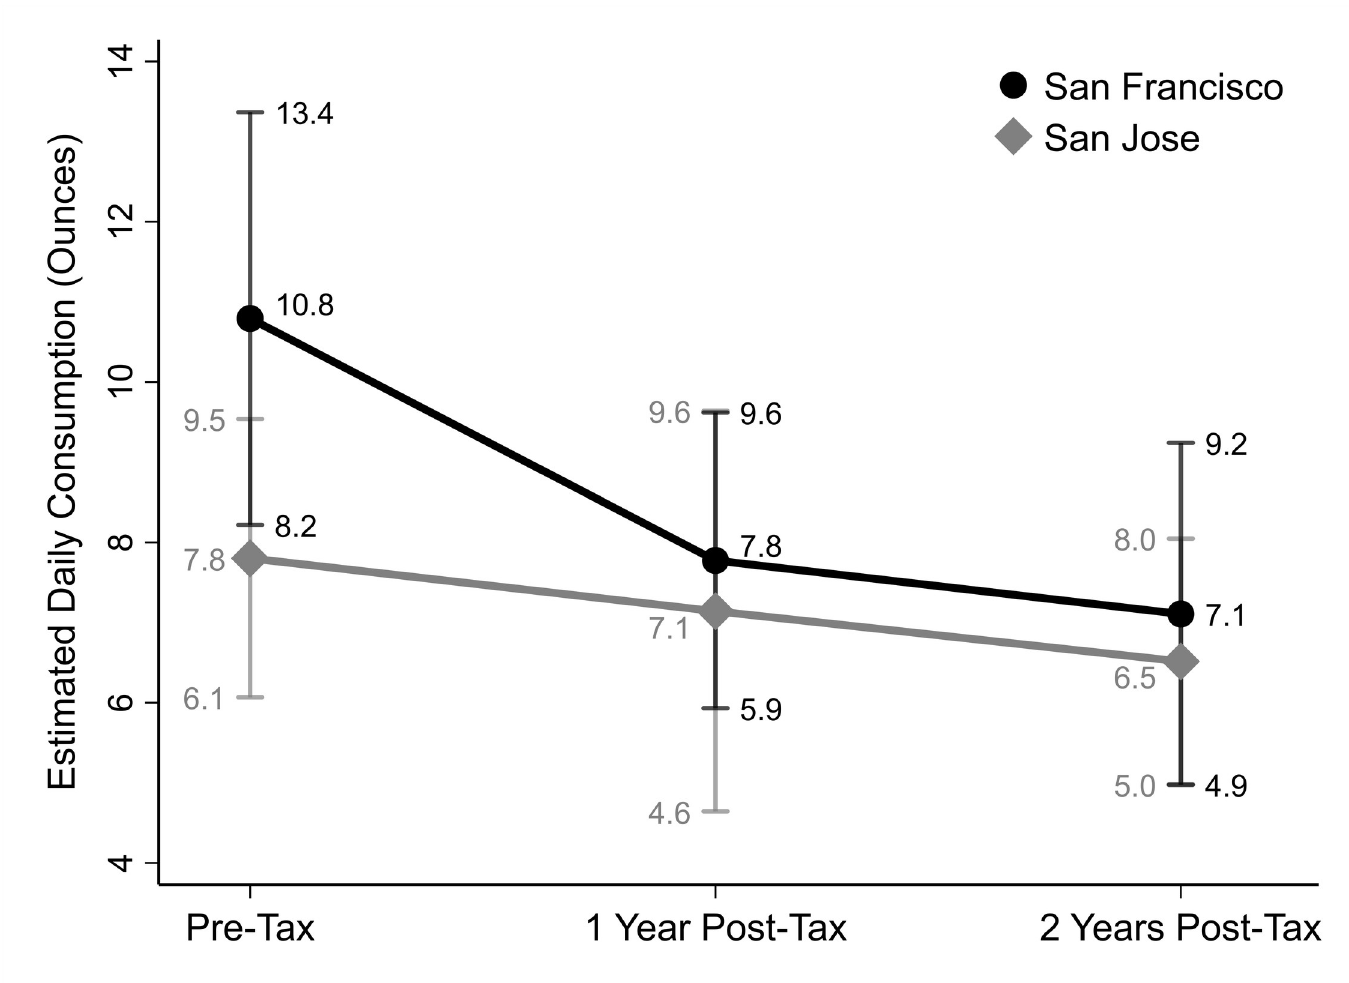
Fig 1. Predicted mean consumption of sugar-sweetened beverages (ounces) with 95% confidence intervals in San Francisco and San Jose´ before, one, and two years after San Francisco’s sugar sweetened beverages tax implementation (n = 1,443). Note: Results based on Gamma GLM with 2-way interactions between time